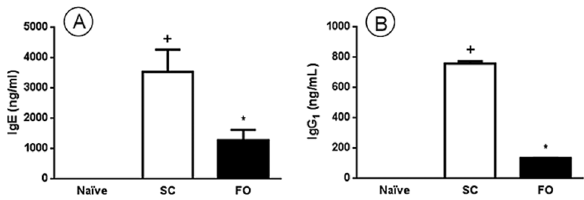
Figure 6. Effect of FO intake on allergen-induced serum IgE and IgG1 in A/J mice. Sensitized (SC) and sensitized, with fish oil (FO). In the signaled cases, P <0.05 compared with the Naive group (+) and the SC group (*) (one-way ANOVA and post-hoc Holm-Sidak test). Values are the means ± S.E.M. and are representative of 1 experiment (n=7 per group).